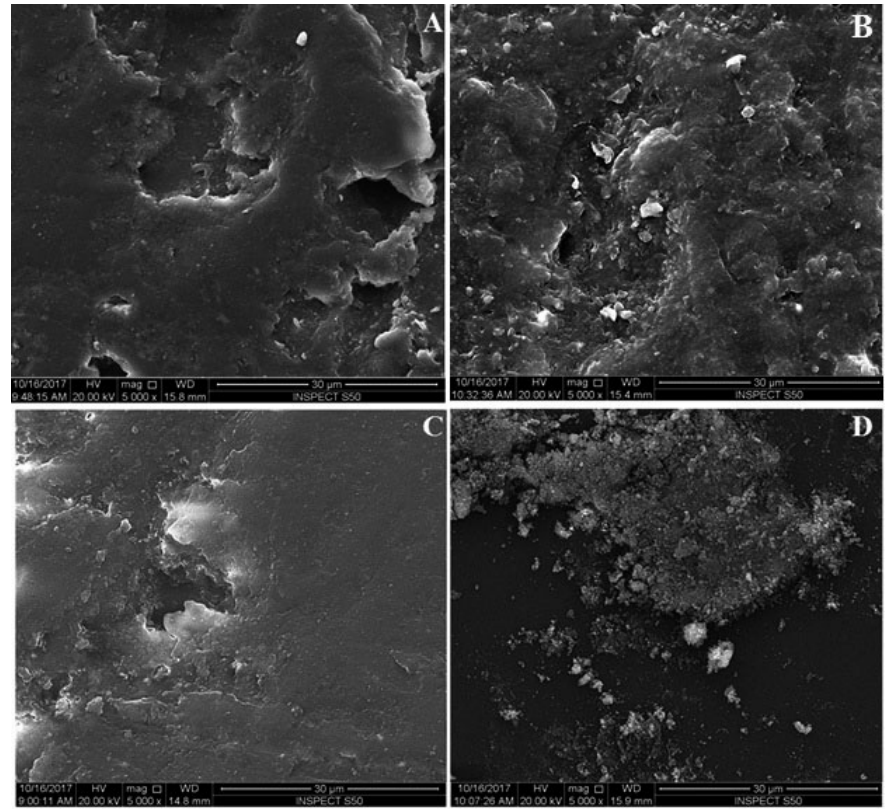
Figure 3- Representative SEM images of the tested specimens’ surfaces. (A) Unmodified specimens; (B) 0.5% ND concentration; (C) 1% ND concentration; (D) 1.5% ND